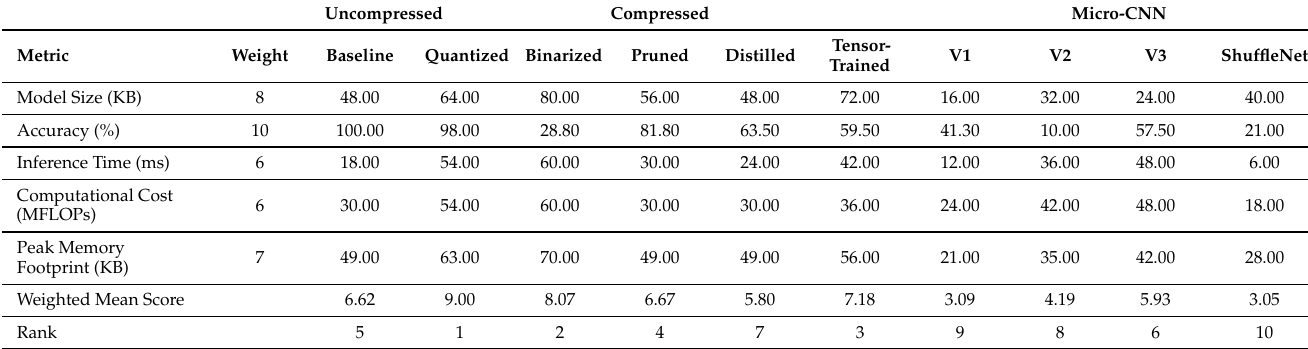
Table 5. Compressed models, base model, and micro-CNN models ranked by the weighted mean